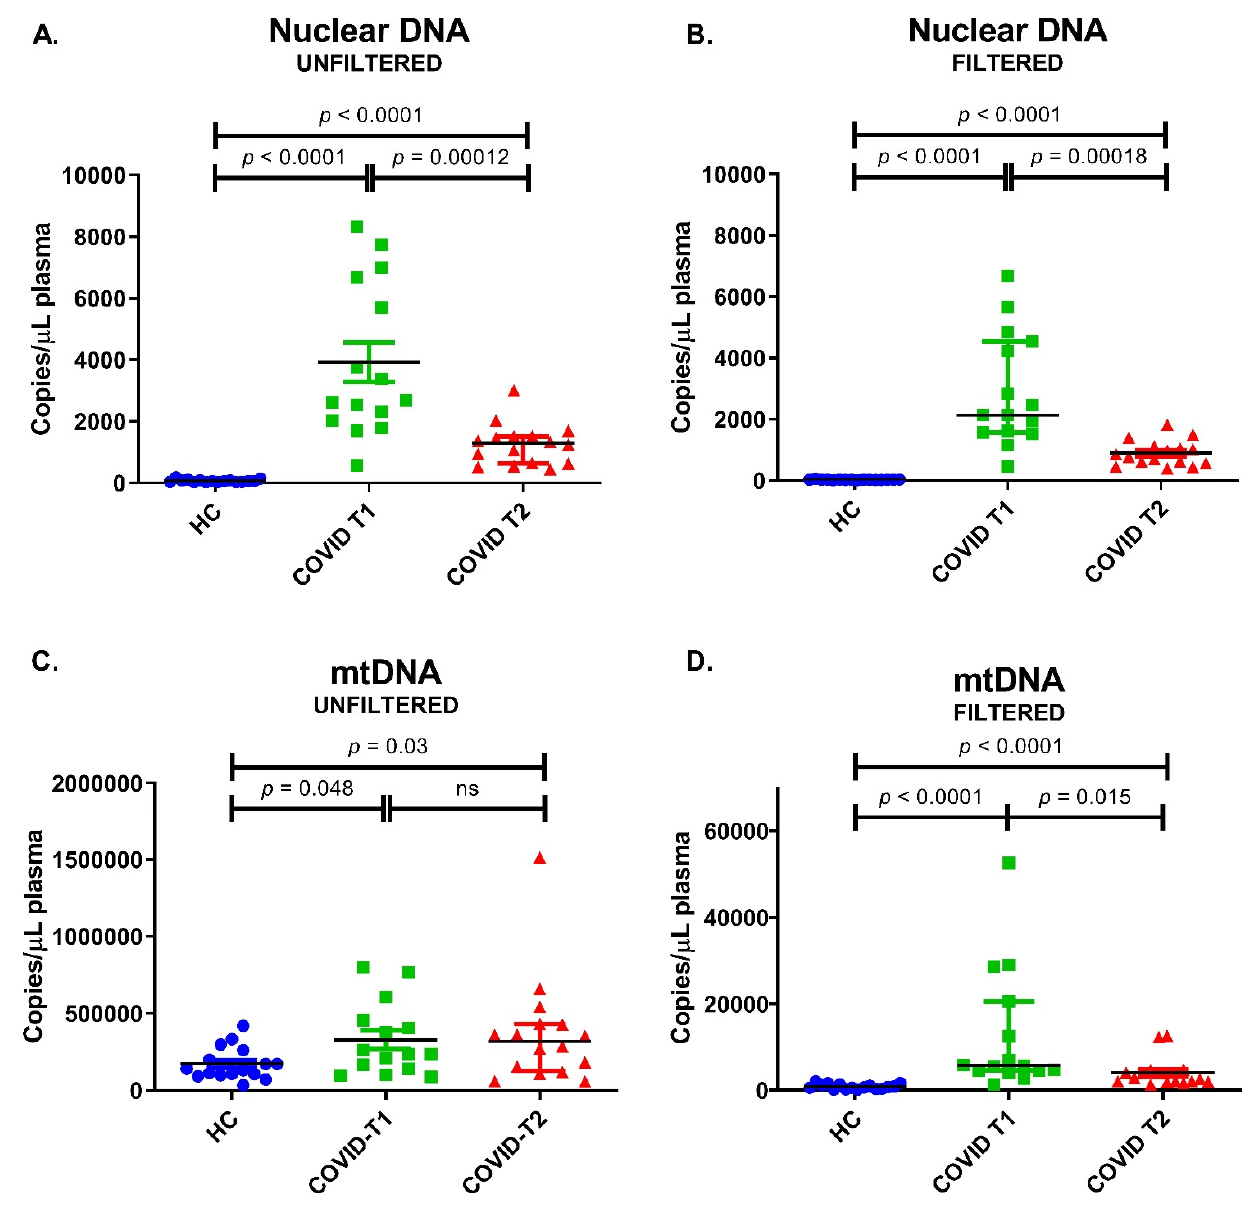
Figure 6. Plasma amount of nuclear DNA ( β -globin) and mitochondrial DNA (mtDNA) in HC = healthy controls, COVID-T1, and COVID-T2 groups. ( A ) Unfiltered nuclear DNA amount. ( B ) Filtered nuclear DNA amount. ( C ) Unfiltered mtDNA. ( D ) Filtered mtDNA. Values are displayed as median ± IQR. Table 2. Plasma amount of nuclear DNA ( β -globin) and mitochondrial DNA (mtDNA) in HC = healthy controls, COVID-T1, and COVID-T2 groups before and after filtration. Filtered mtND1. ( n = 15–16). Values are displayed as median (IQR).